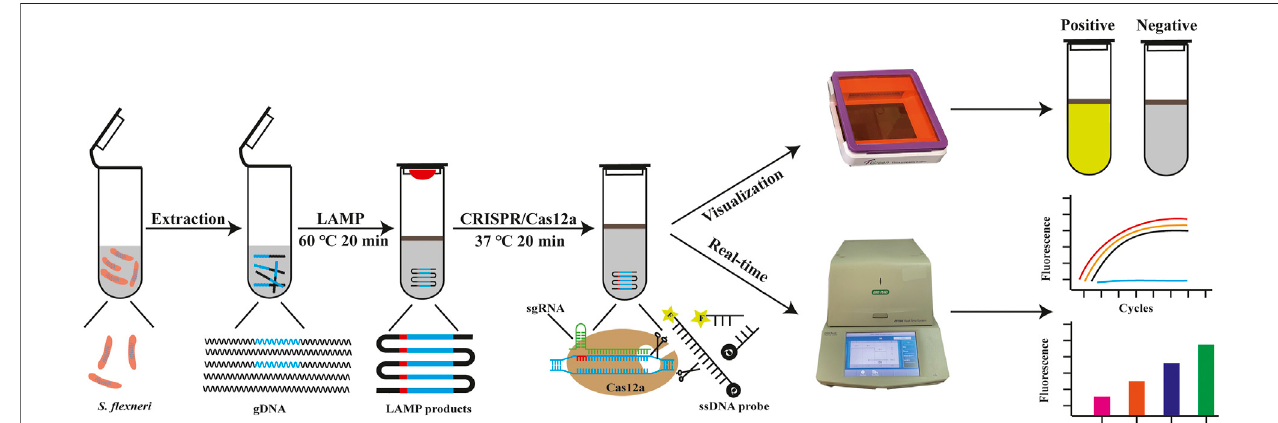
FIGURE 1 | The outline of CRISPR/Cas12a-E-LAMP detection system. In the CRISPR/Cas12a-E-LAMP method, the gDNA of S. fl exneri was extracted and then used in the LAMP reaction (10 μ l) at 60 ° C for 20 min and covered by 20- μ l mineral oil. The Cas12a reaction reagents (20 μ l) was pre-placed in the lid and mixed with LAMP products at 37 ° C for 20 min. Once the Cas12a fi nd the PAM site and the sgRNA complementary pairing with the target DNA, Cas12a endonuclease is activated. Then, Cas12a endonuclease cis-cleavage the LAMP products and split the ssDNA-FQ reporter indiscriminately by trans-cleavage, generating the fl uorescence signal visible to the naked eye under LED blue